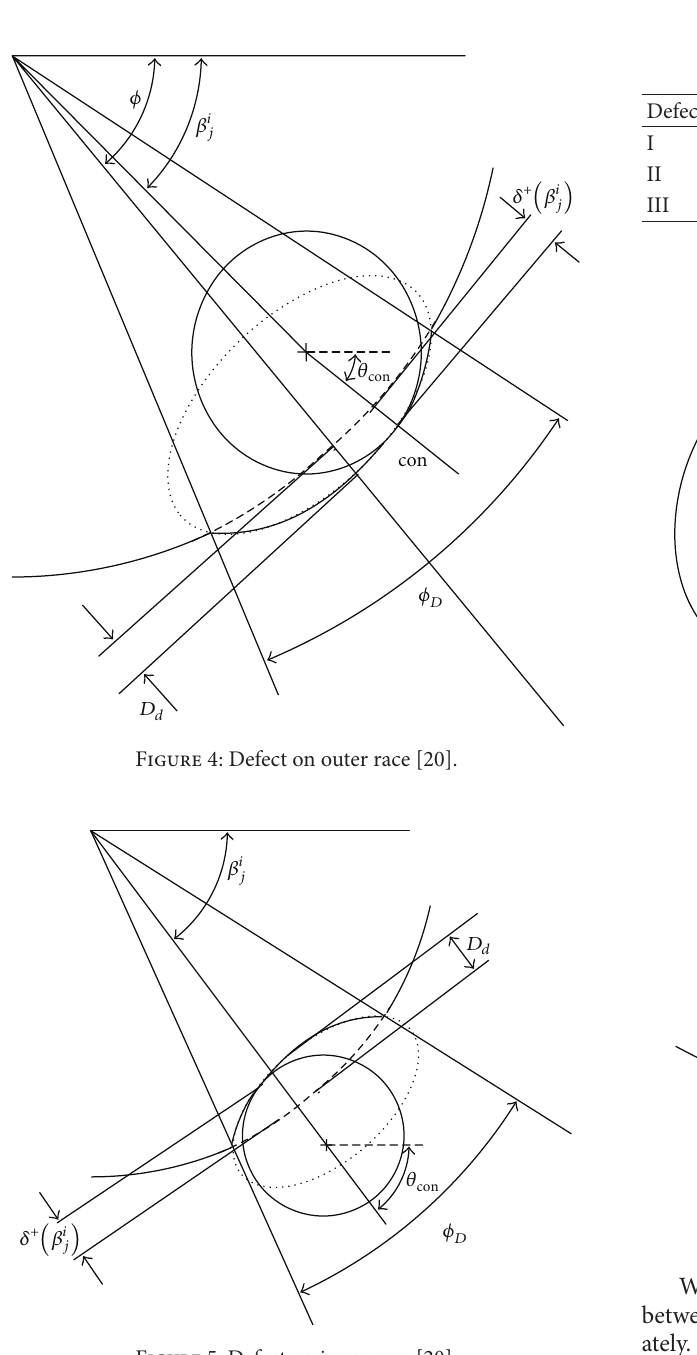
Figure 5: Defect on inner race [20].